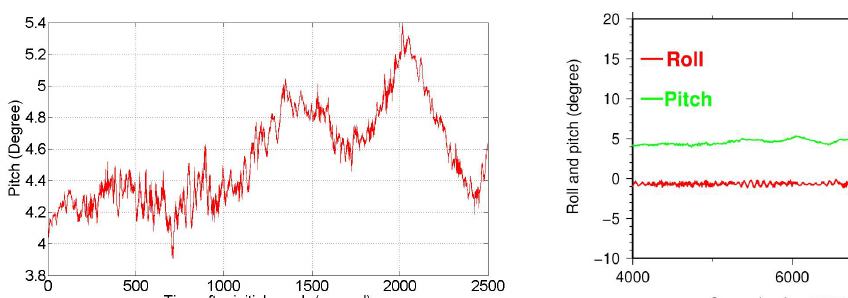
Figure 9. The attitude angles along the track of Flight